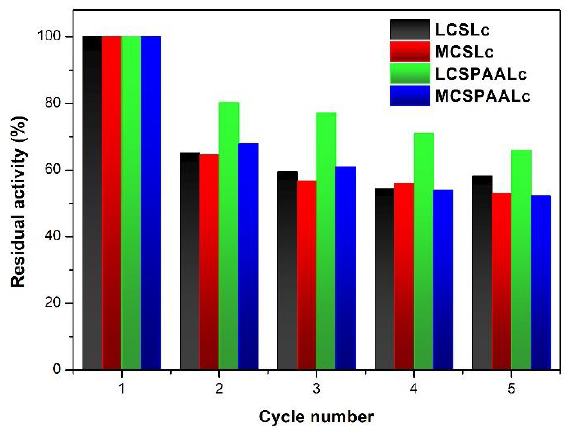
Figure 10. Reusability of immobilized products used for MR discoloration.